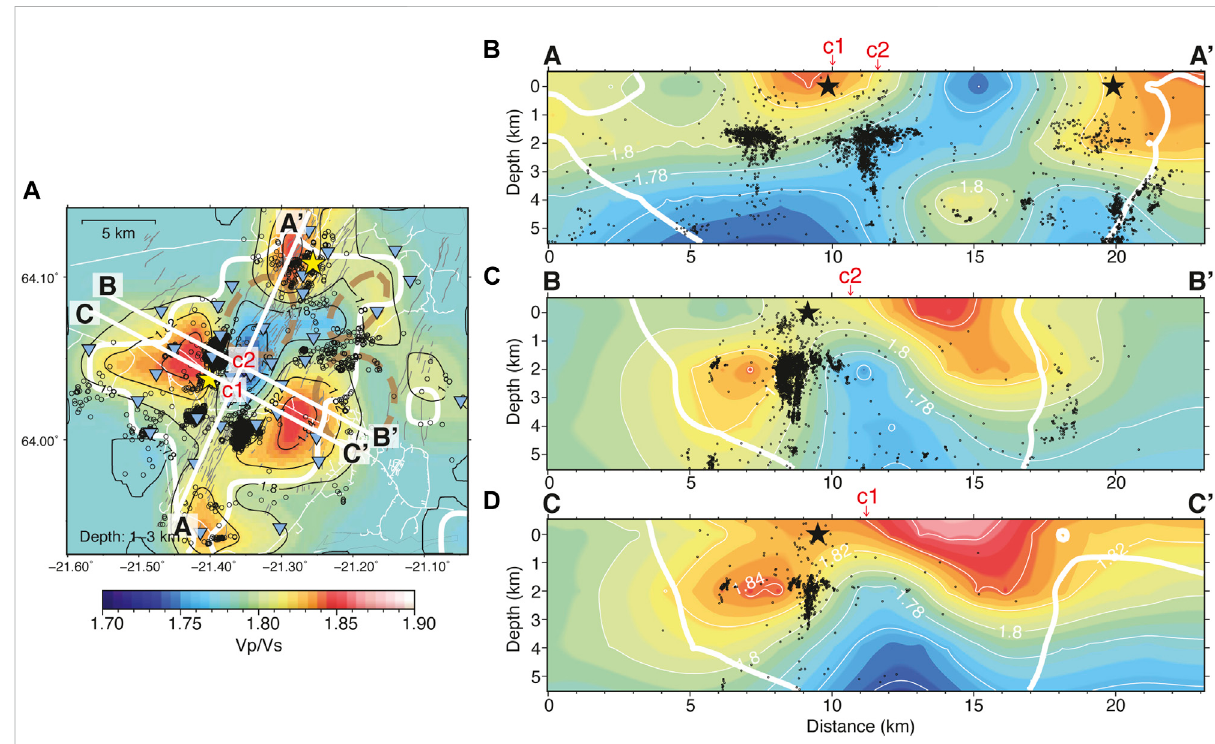
FIGURE 6 Vertical cross-sections through the Vp/Vs model along the paths shown in (A) . The stars mark the location of the power plants. The seismicity 2 km around each transect is superimposed on the fi gures and shown as black dots. The white thick lines mark the well resolved area with an RDE >